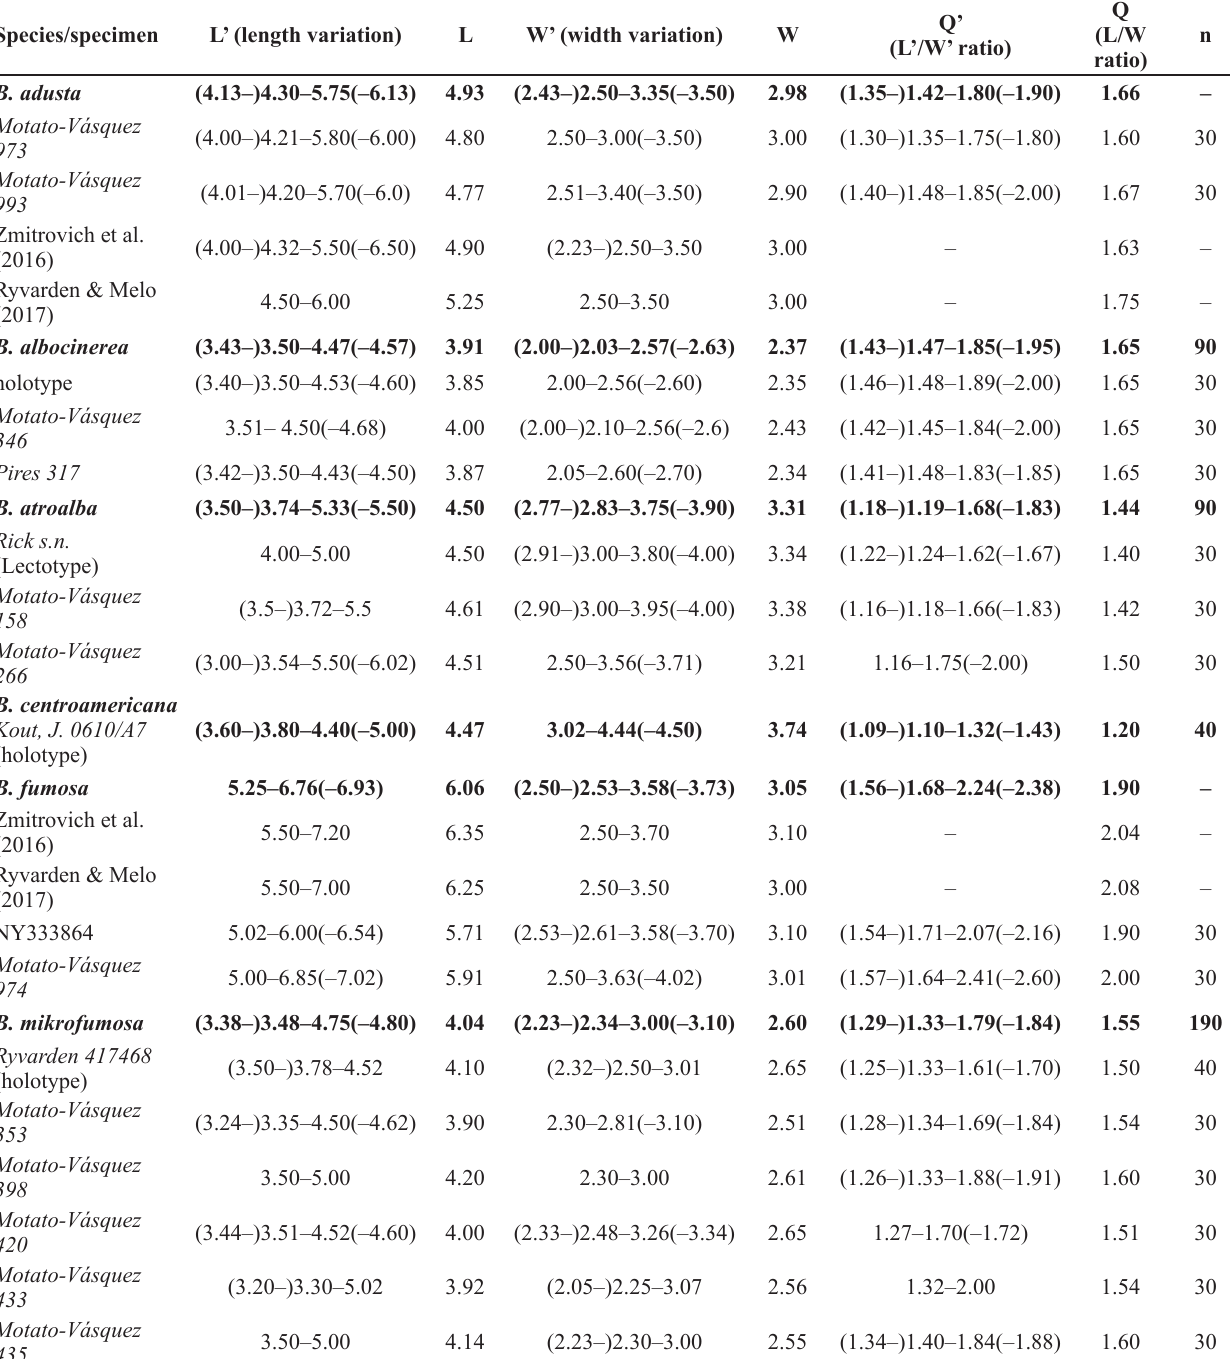
Table 2 – Basidiospores measurements (µm) of six Bjerkandera species. For L’ and W’, the 5% extreme tails are given in parentheses. When literature is indicated the number of measurements and Q’ values are